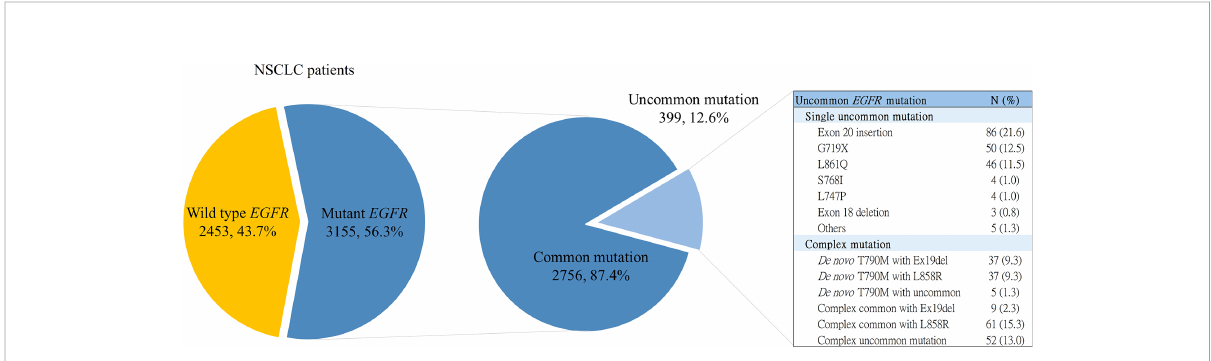
FIGURE 1 NSCLC patients receiving EGFR mutation testing and distribution of uncommon EGFR mutation. EGFR , epidermal growth factor receptor; Ex19del, exon 19 deletion; NSCLC, non-small cell lung